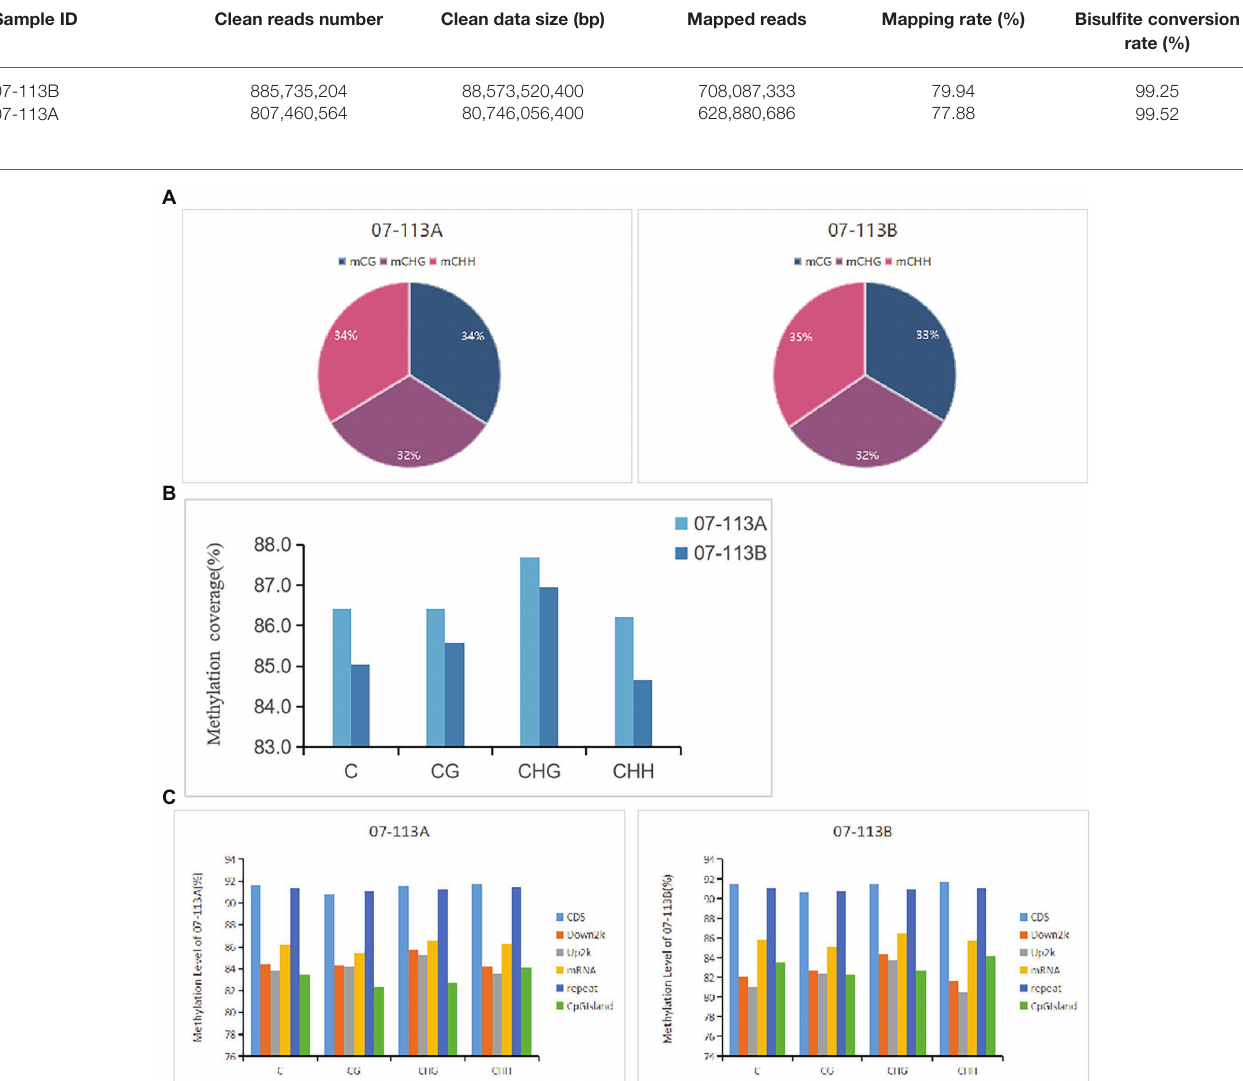
TABLE 1 | Sequence reads generated by whole-genome BS-Seq in 07-113A and